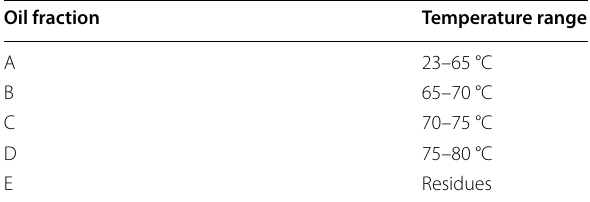
Table 1 Fractionation conditions of the essential oil of